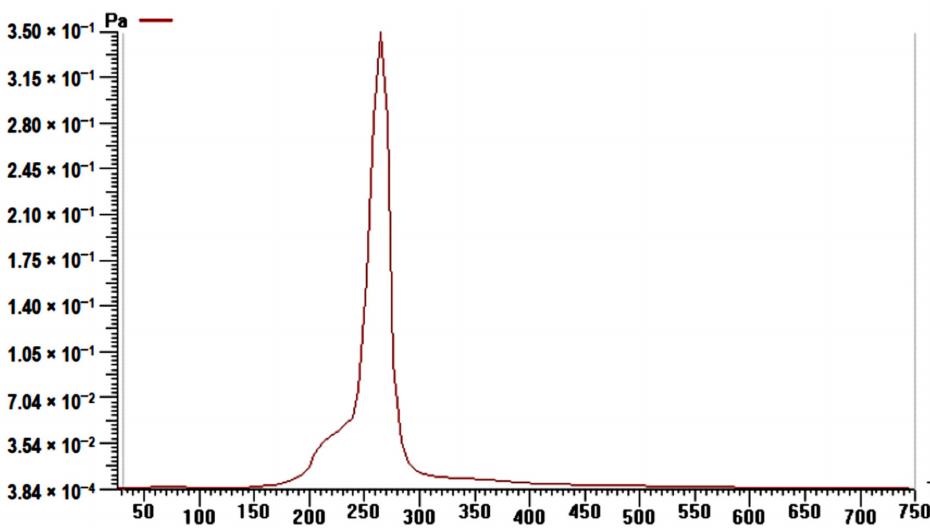
Figure 5. Temperature–pressure (P-T) curves of rice